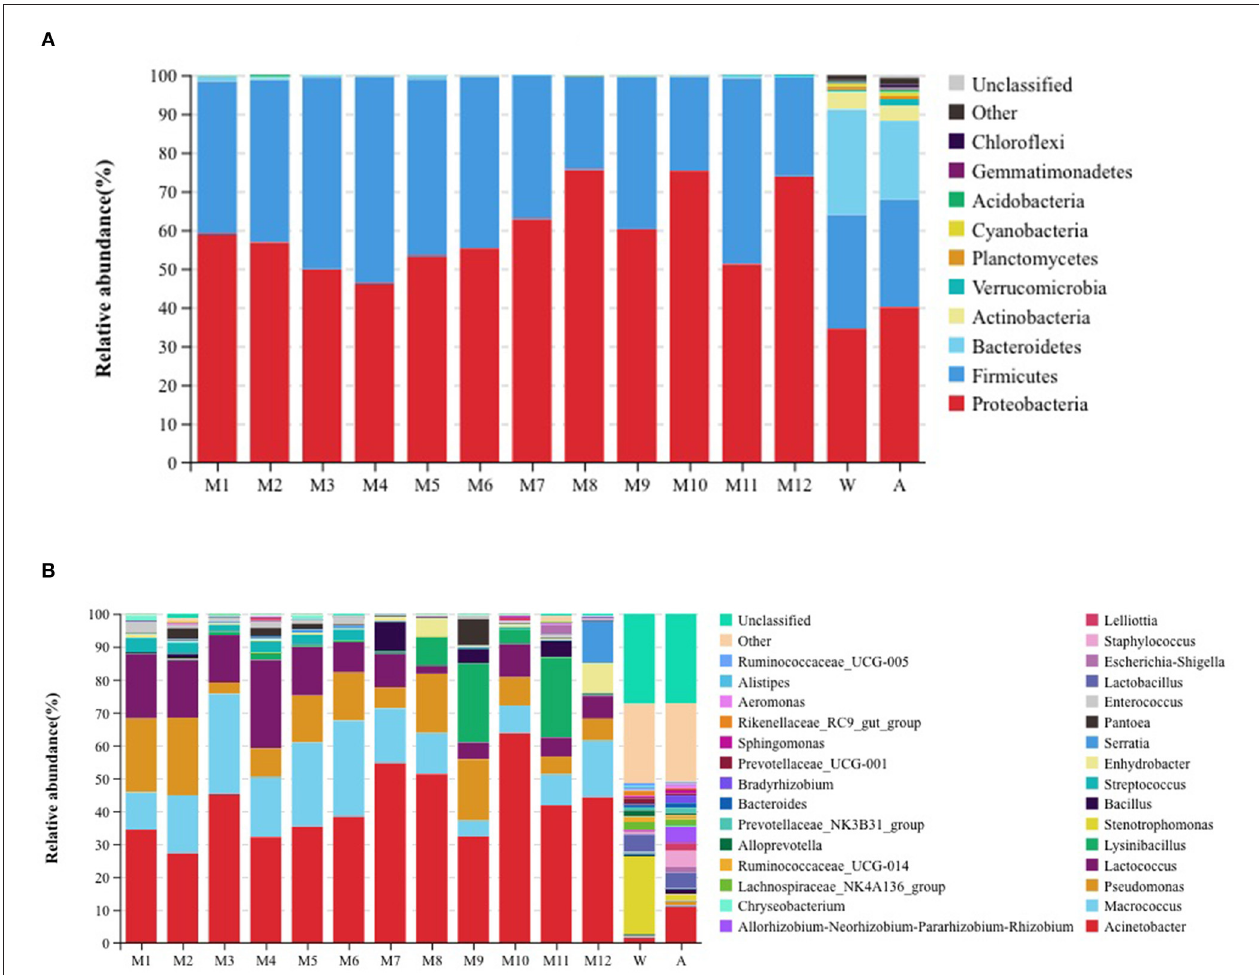
FIGURE 1 | Relative abundance of operational taxonomic units at the (A) phylum and (B) genus level for the different samples. W: equipment water rinses, A: processing factory air. M1: milk tanker (raw milk); M2: storage tank (raw milk); M3: storage tank for processing (raw milk); M4: milk in balance tank (72 ◦ C/15s); M5: milk in balance tank (75 ◦ C/15s); M6: milk in balance tank (80 ◦ C/15s); M7: milk in product tank (72 ◦ C/15s); M8: milk in product tank (75 ◦ C/15s); M9: milk in product tank (80 ◦ C/15s); M10: pasteurized milk (72 ◦ C/15s); M11: pasteurized milk (75 ◦ C/15s); and M12: pasteurized milk (80 ◦ C/15